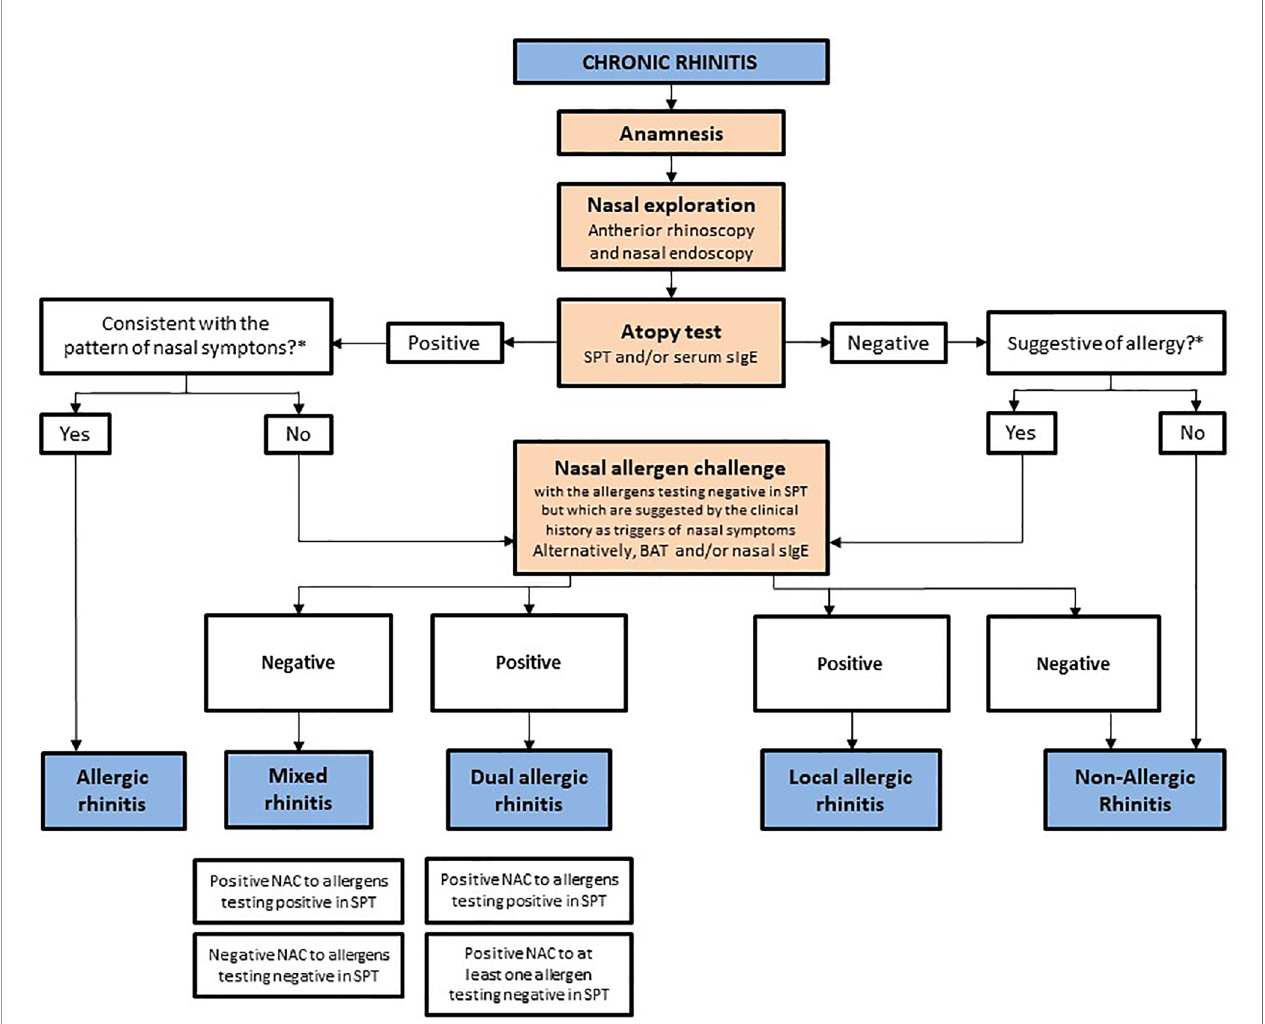
FIGURE 2 | Diagnostic algorithm of chronic rhinitis phenotypes. BAT, basophil activation test; NAC, nasal allergen challenge; sIgE, allergen-speci fi c IgE; SPT, skin prick test. *The interrogation about the seasonality and severity variations of nasal symptoms, and about the speci fi c (vegetation, furry animals, dust, etc.) and unspeci fi c triggers of rhinitis (rapid changes in temperature or humidity, irritant smells, etc.) are useful means to investigate the likelihood of an allergic etiology for the disease or to evaluate whether positive skin prick test results are consistent with the symptoms